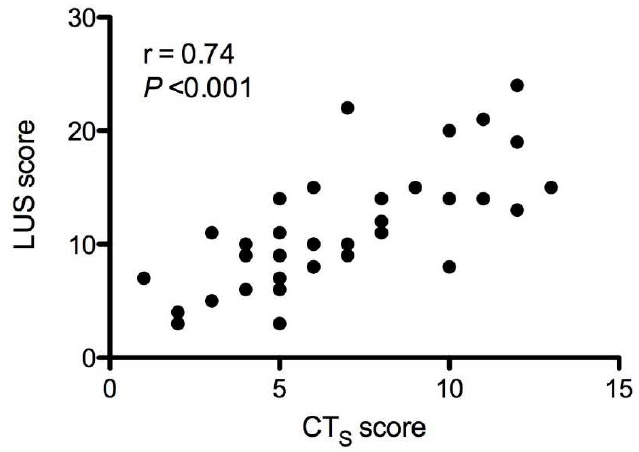
Figure 5. Pearson’s correlation for CTs and LUS score.